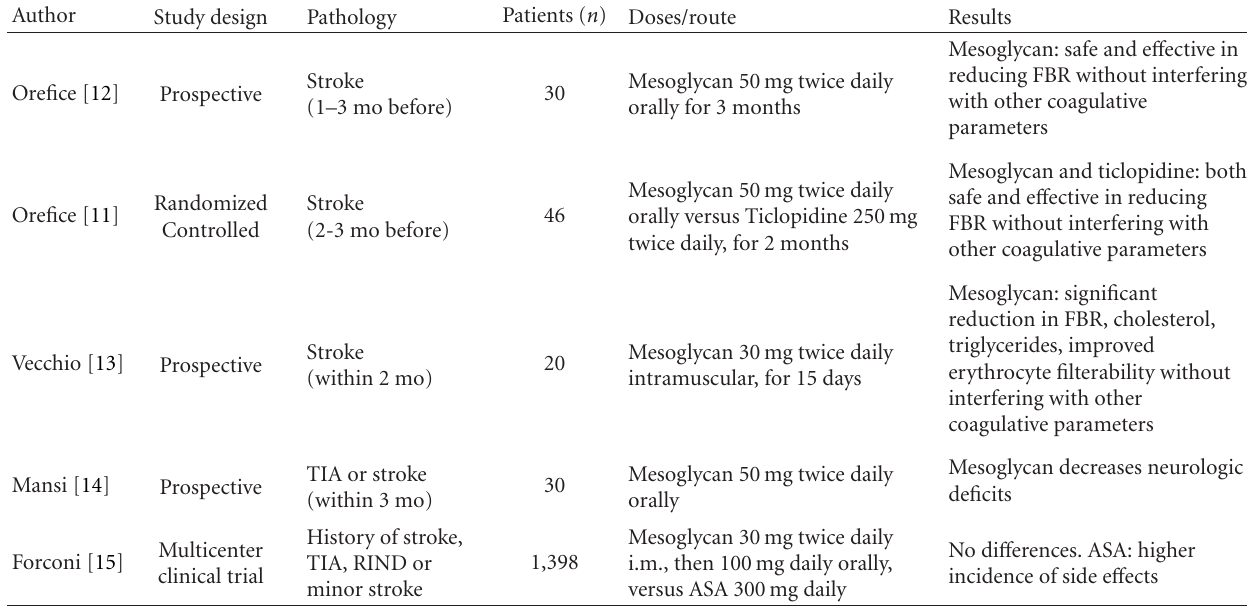
Table 1: Mesoglycan in ischemic stroke. Clinical